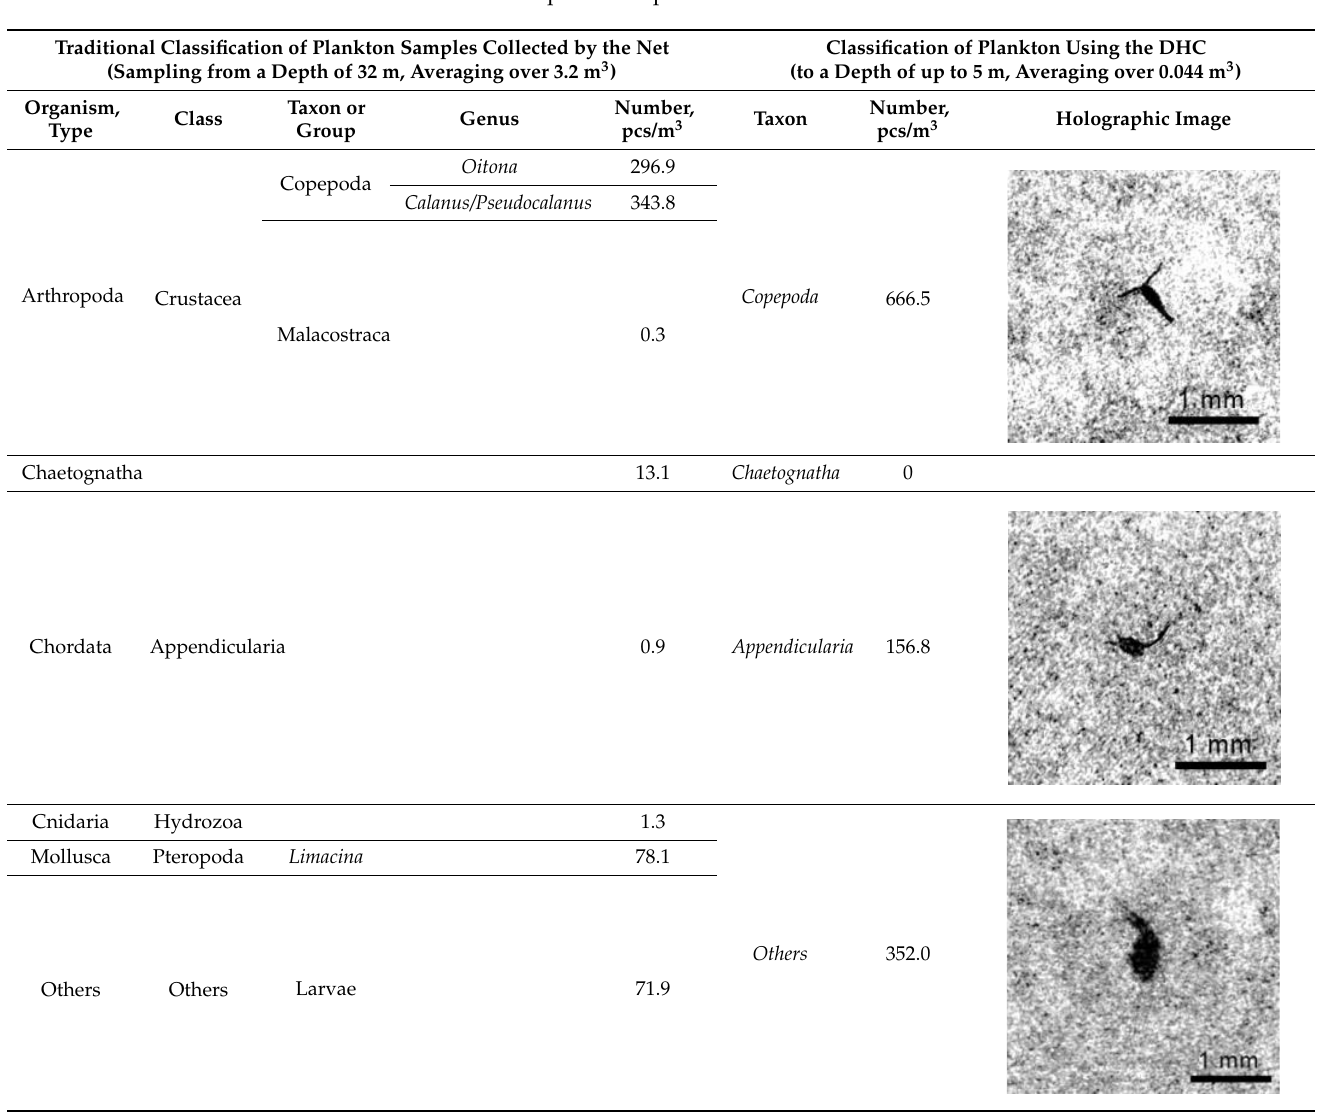
Table 5. Data for comparison of plankton measurements at station No. 6995.